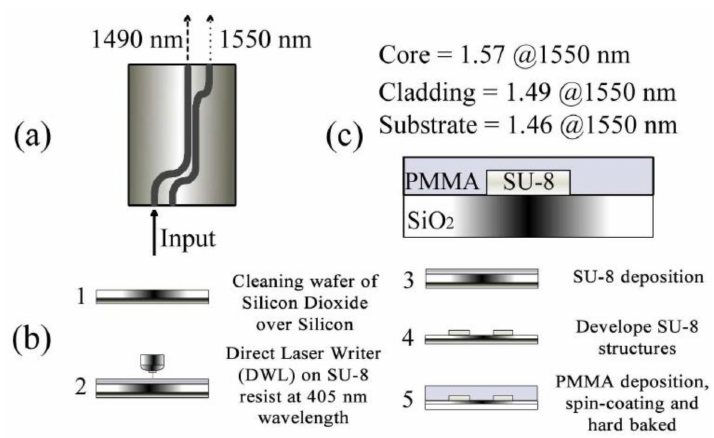
Figure 12. ( a–c ) Schematic diagram and manufacturing steps of directional coupler [71].